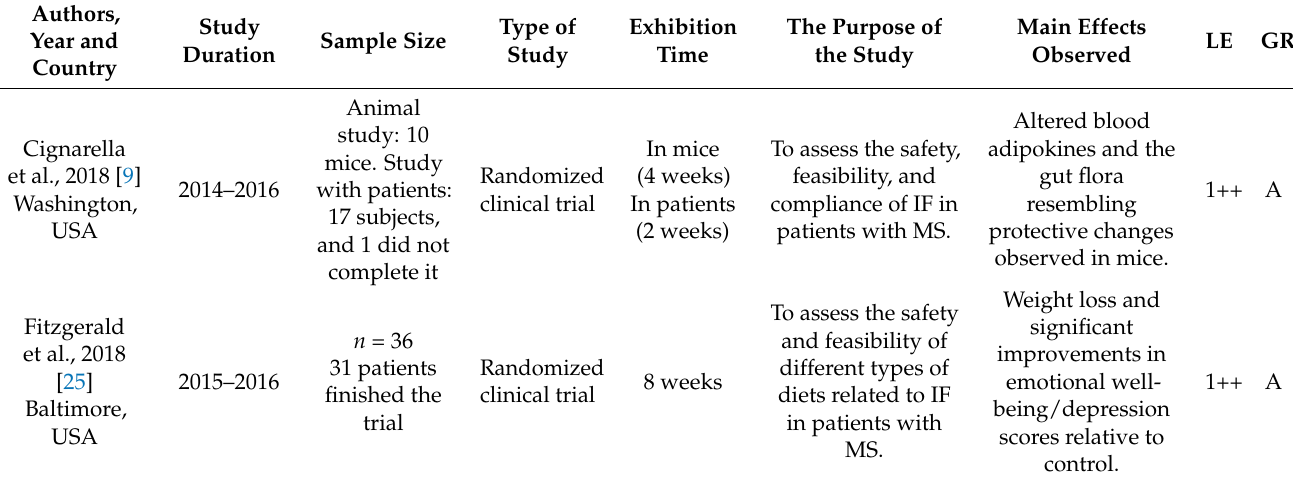
Table 3. Studies identified on intermittent fasting (IF) and effects on multiple sclerosis (MS).